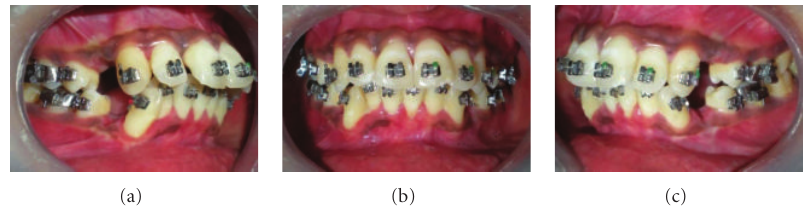
Figure 7: (a, b, c) 0.022 (cid:3)(cid:3) PEA appliance strapped up, all four 1st premolars extracted.